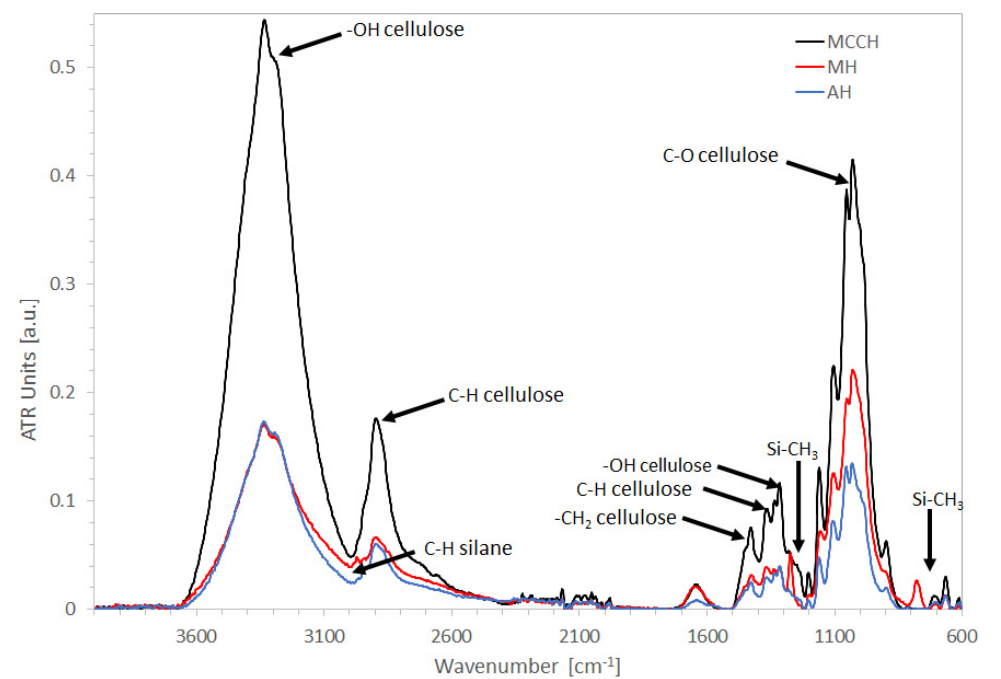
Fig. 2 FT-IR spectra of MCCH, MH and